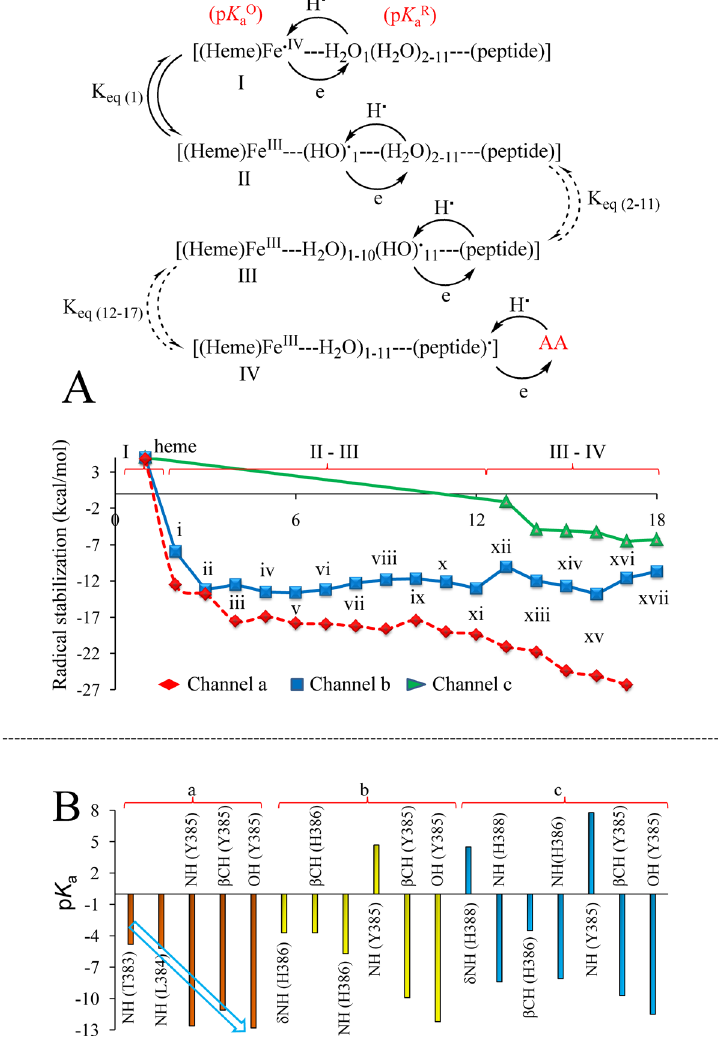
Figure 4. Simulations over the COX-2–AA–heme complex: ( A ) Equilibria between the consecutive steps of the H · /e transfer process and the corresponding radical stabilization of three channels (i–xviii, Fig. 1C) ( B ) p K a of the peptide participating groups of the three channels. All values with SD ± 0.5